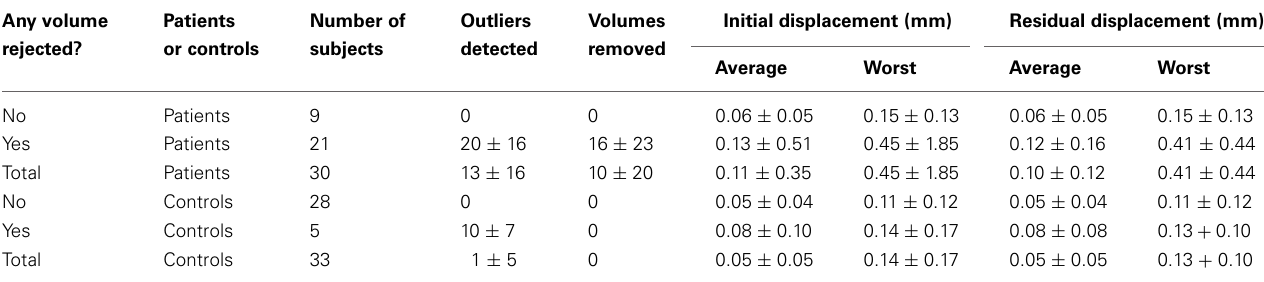
Table 1 | Statistics on the rejection of realignment-outlier volumes.